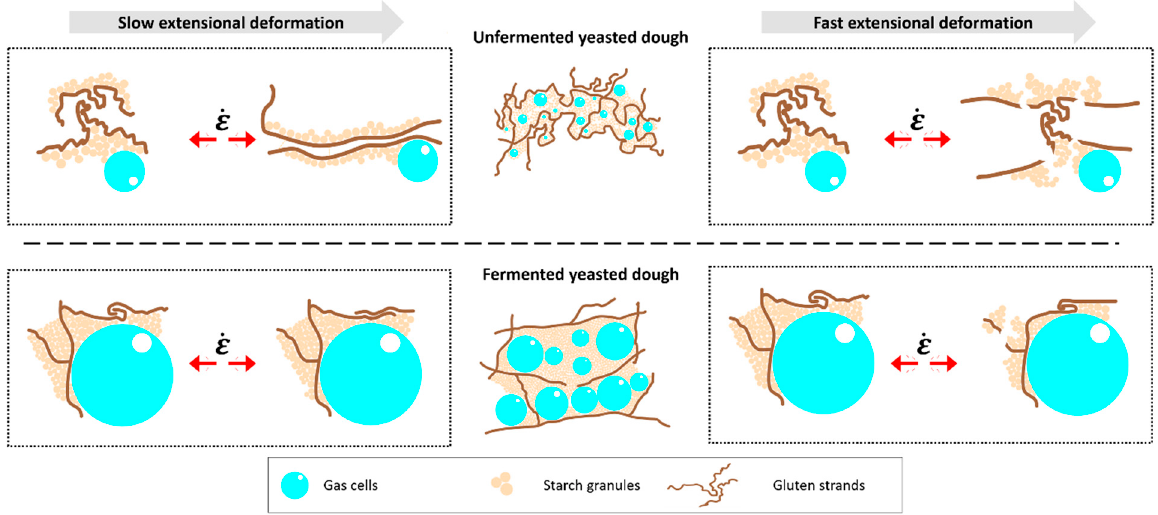
Figure 5. Schematic illustration presenting the hypothesised network model during extension processes for unfermented and fermented dough, describing the observed effects from Figure 4. The scheme illustrates the possible pathways for slow (left) and fast (right) extension rates ( (cid:2239)(cid:4662) ) of unfermented (top) and fermented (bottom) dough matrix. The underlying information on the gas void fraction present in unfermented and fermented dough are 0.1 and 0.75, respectively [42].